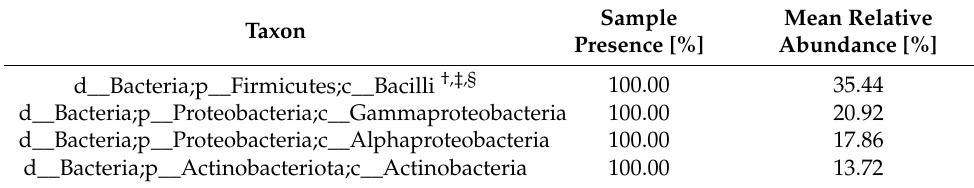
Table 2. Dominant classes among EBC samples, in consecutive